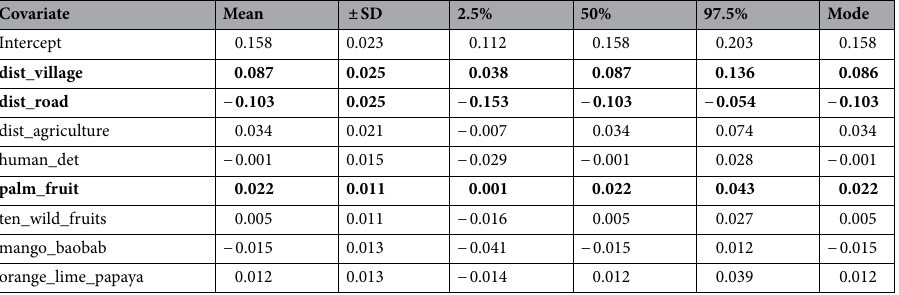
Table 1. Posterior estimates of the chimpanzee spatiotemporal model. Values show the posterior mean of the intercept and covariate coefficients β for the final model, including standard deviation, credible interval quantiles and mode. Bold indicates covariates where credible interval does not cross the zero value. (Final model DIC = − 737.2343, compared to no-covariate model DIC = − 683.9679, ΔDIC = 53.27. See Supplementary Table S5 or the full list.). dist_village = linear distance to the nearest village; dist_road = linear distance to the nearest road; dist_agriculture = linear distance to the nearest agricultural area (including cashew orchards, shifting cultivation fields and mangrove rice cultivations); human_det = human detection frequencies, or human intensity of space use including missed observations as predicted by the human spatiotemporal model (Supplementary Table S3); palm_fruit = availability of ripe oil palm fruit; ten_wild_fruit = availability of ten wild fruits combined; mango_baobab = availability of ripe mango and baobab fruit combined; orange_lime_ papaya = availability of orange, lime and papaya combined (village-only